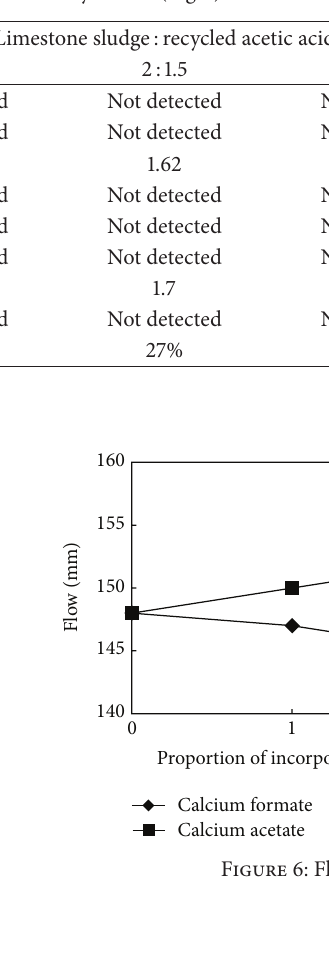
Table 8: ICP Analysis of heavy metals (mg/ ℓ ).